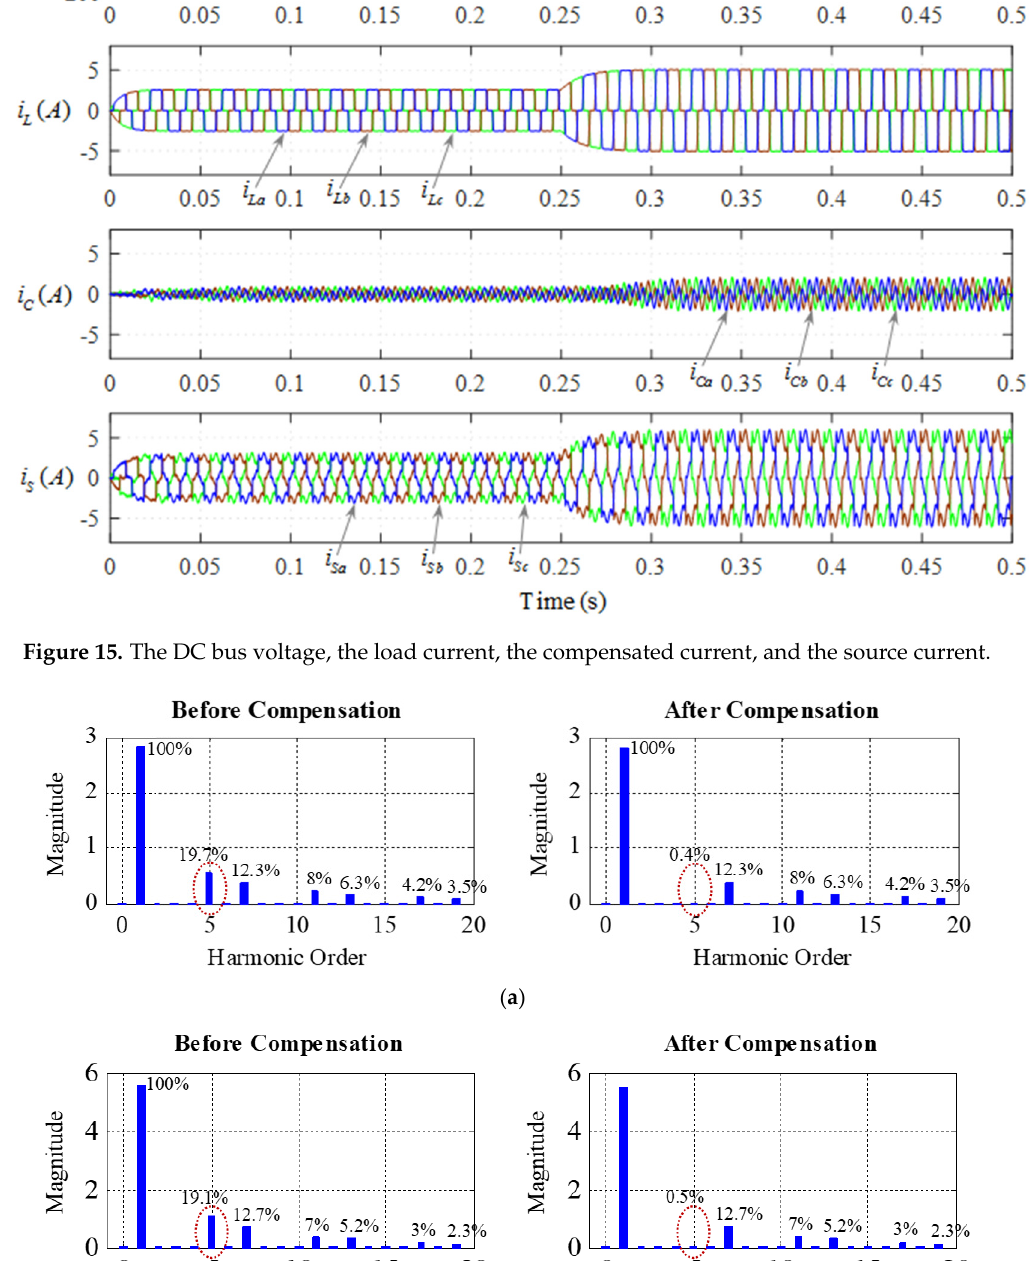
Figure 15. The DC bus voltage, the load current, the compensated current, and the source current.